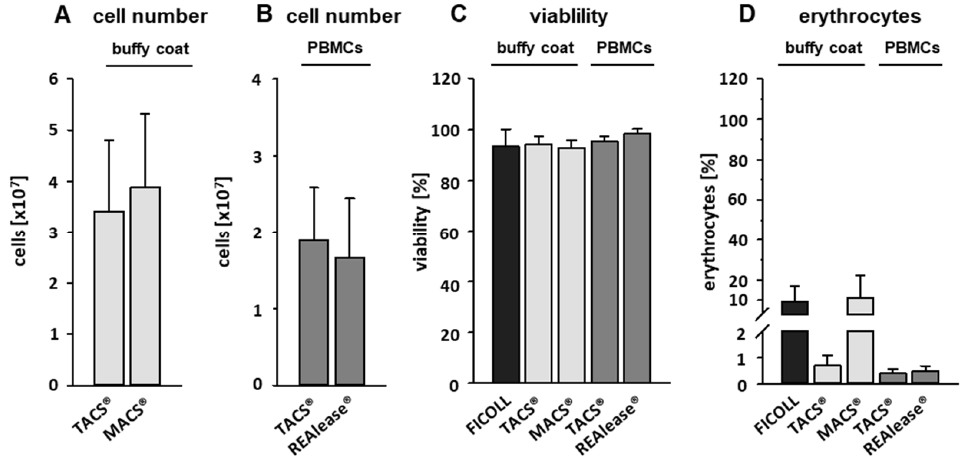
Figure 2. Cell number, viability, and erythrocyte contamination. CD3-positive cells were either separated from buffy coats by the MACS ® and TACS ® system or from PBMCs by the TACS ® and REAlease ® system. Cell numbers ( A , B ) were determined by manual counting in a Neubauer chamber. Shown are the mean of cell number ± SD, n = 6 (buffy coat) and n = 5 (PBMCs). The viability ( C ) was measured by FITC Annexin V Apoptosis Detection Kit with PI and contamination with erythrocytes ( D ) by measuring CD235a expression via flow cytometry. Shown are the percentages of viable cells negative for FITC Annexin V and PI ( C ) or positive for CD235a ( D ) ± SD, n = 6.